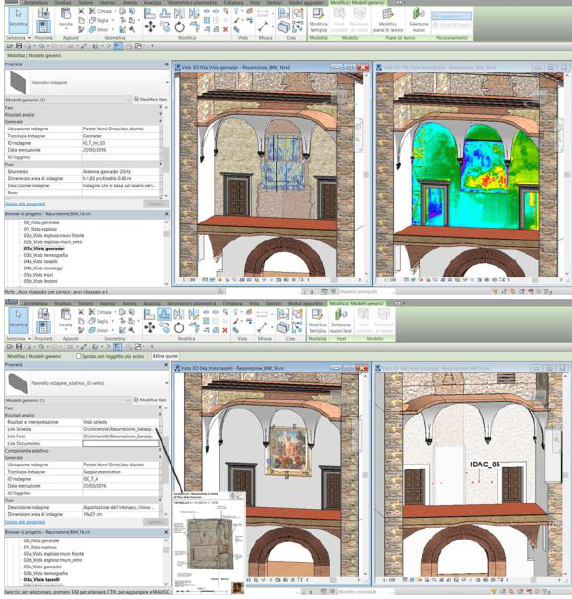
Figure 7. Up: the visualization of georadar and thermography surveys. Down: the visualization of one of the 7 exploratory tests with linked data sheet and of the DAC-tests on the back of the wall with ID